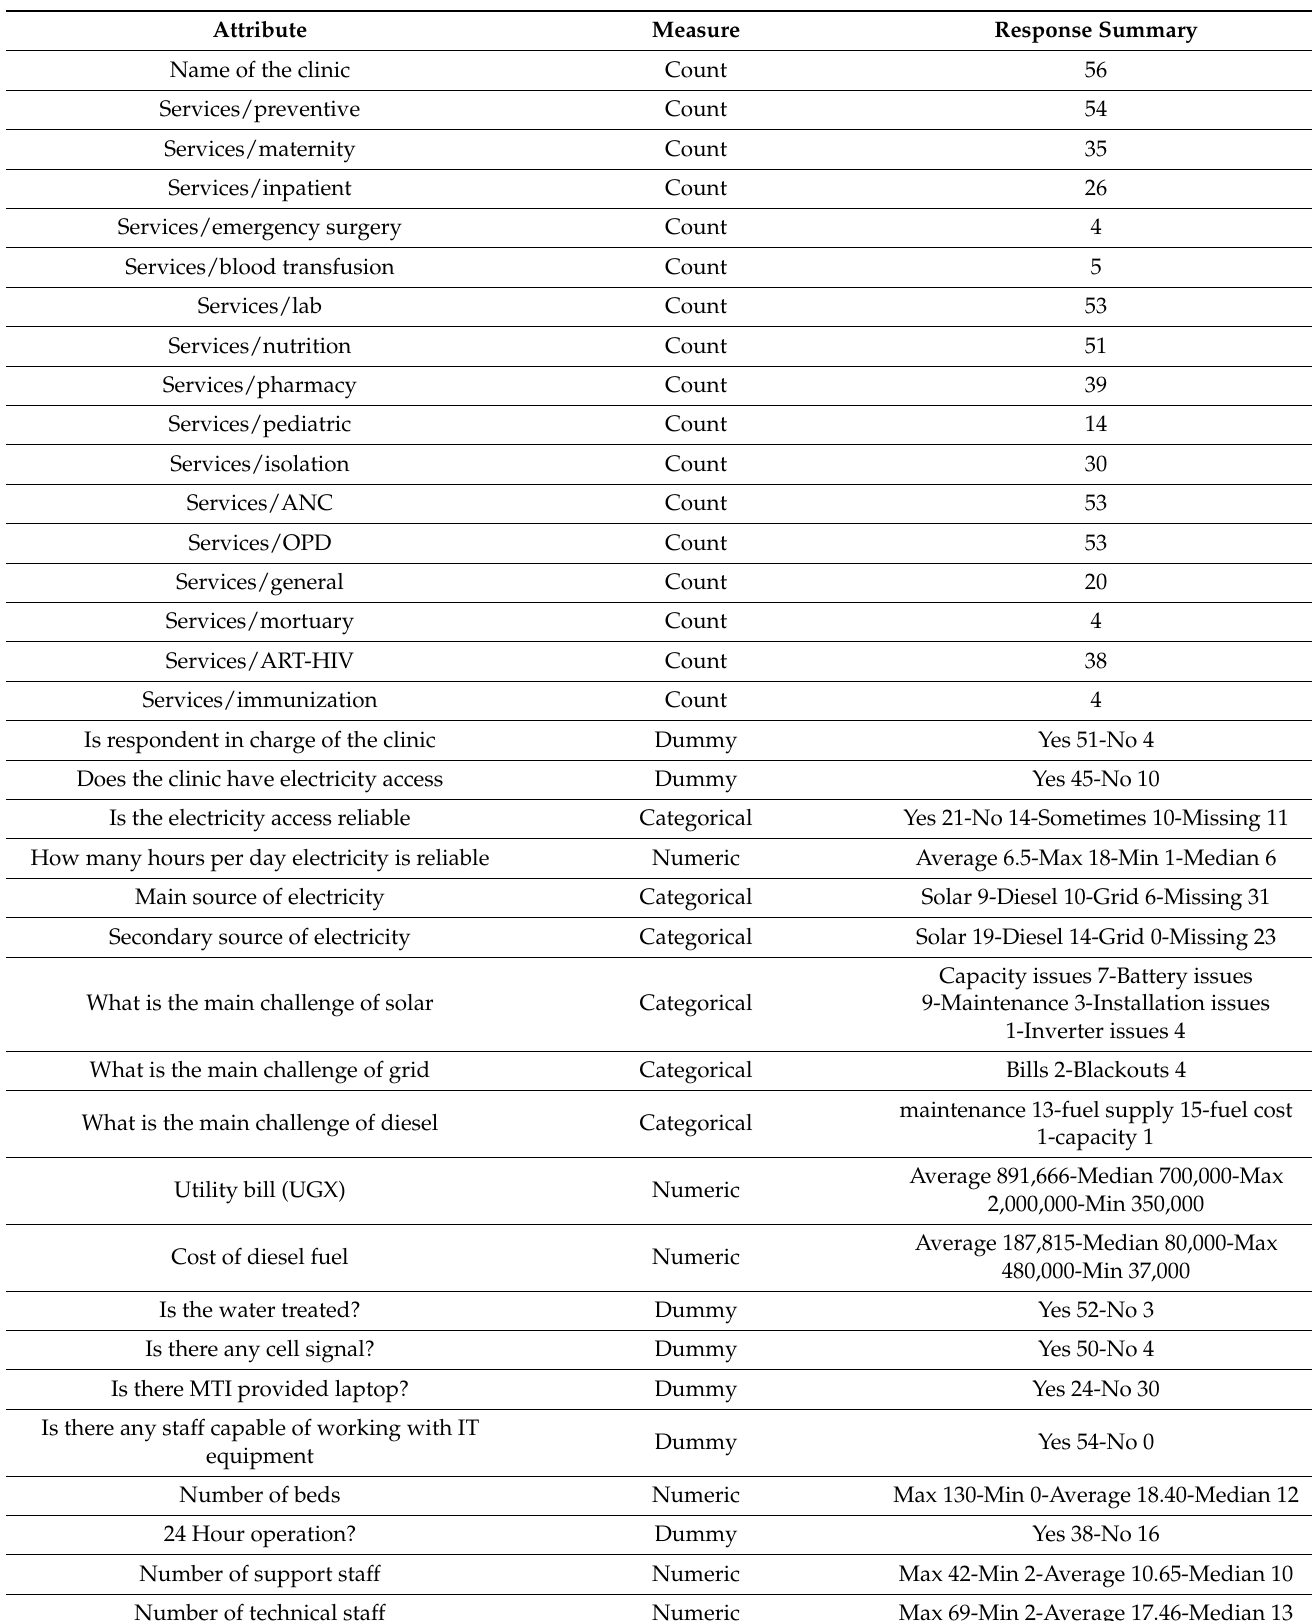
Table A2. Summary of the data collected at HCF